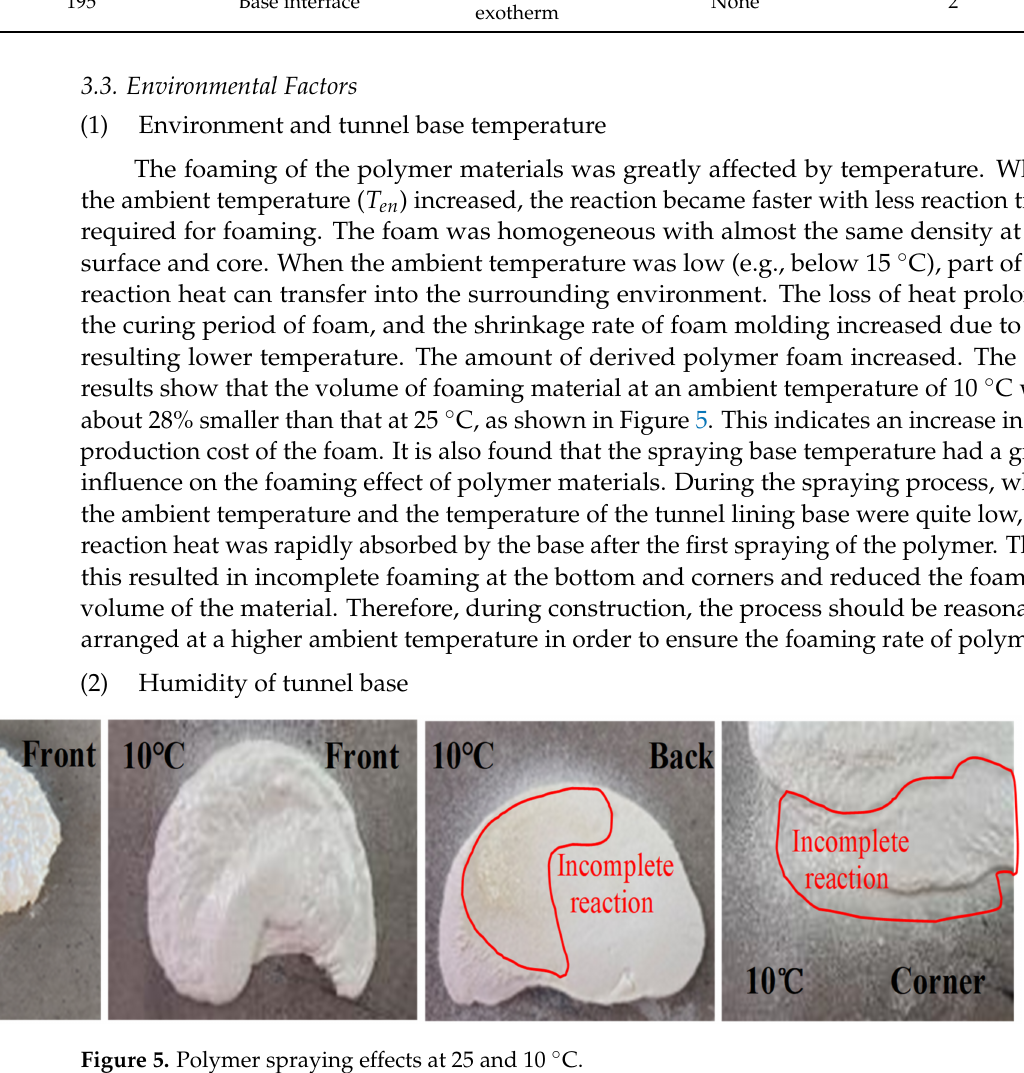
Figure 5. Polymer spraying effects at 25 and 10 ◦